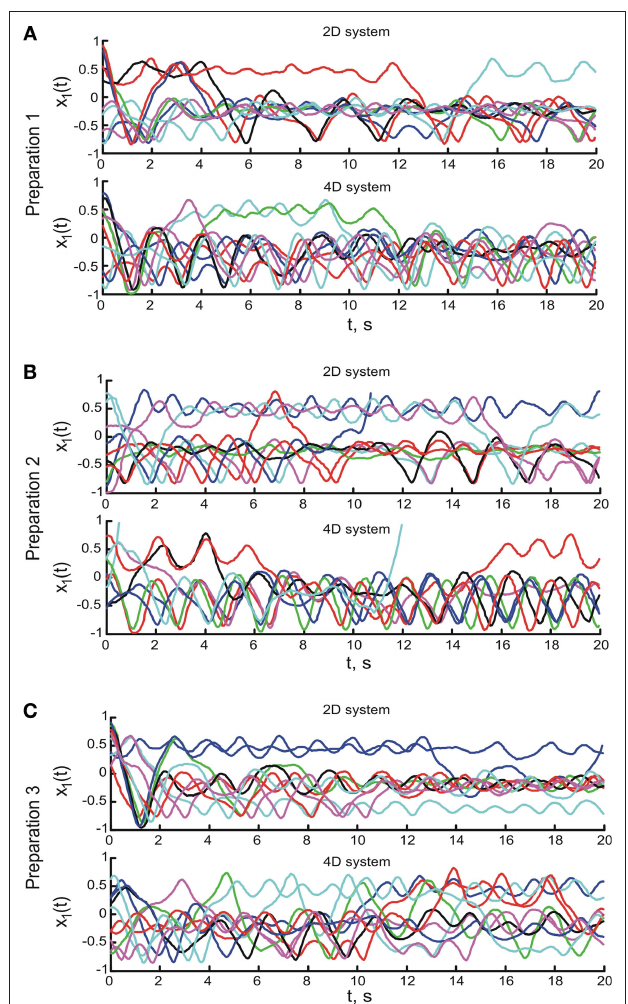
FIGURE 6 | Trajectories of the external dynamical systems obtained during the experiments. (A–C) Show the trajectories for the three preparations respectively. The upper panels show the trajectories obtained using the 2D system, the lower panels show the trajectories obtained using the 4D system. Different colors show different trajectories merely for easier distinction. Note that different trajectories start from different initial positions and